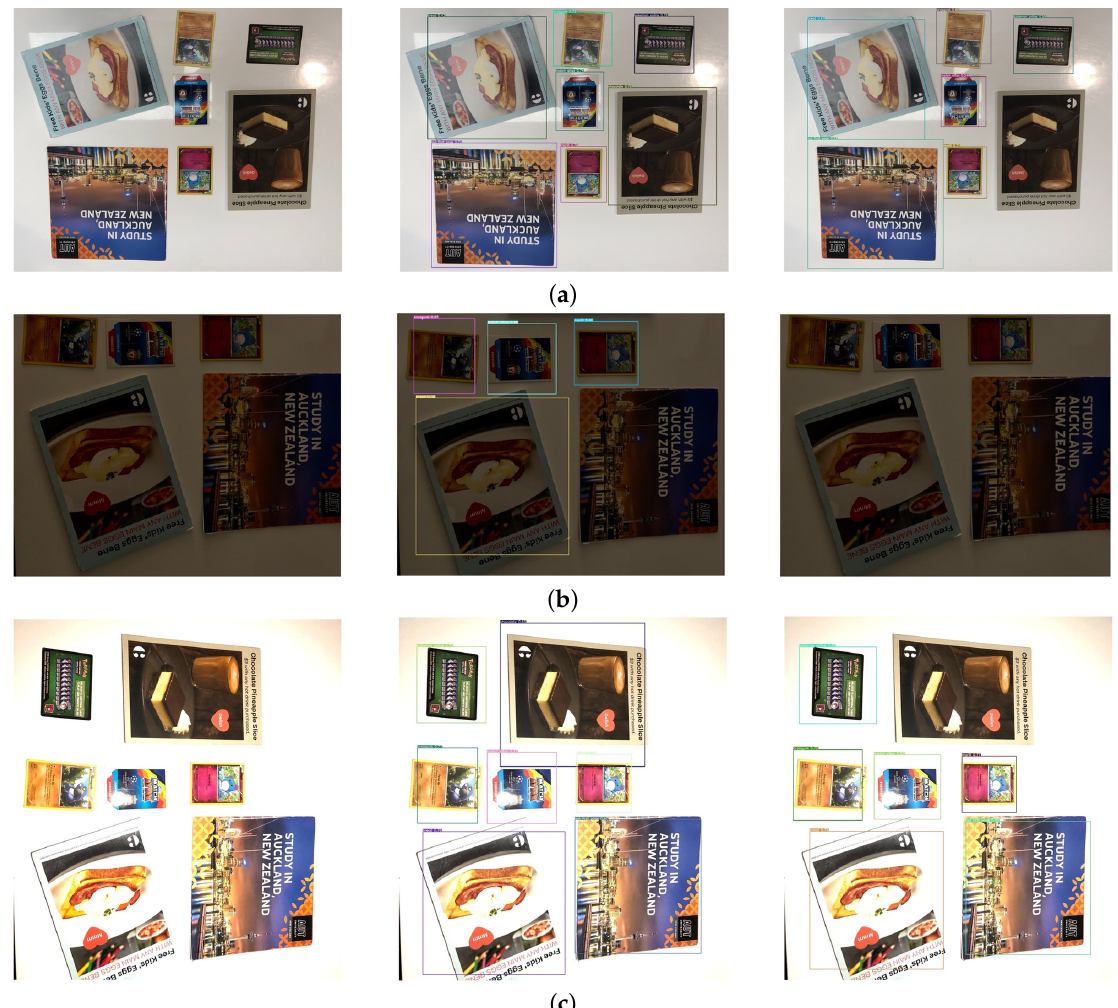
Figure 17. The input real-time images (left column) and detection results under different lighting conditions for the YOLOv3 model (middle column) and YOLOv3 tiny model (right column). ( a ) Indoor lighting; ( b ) Low lighting; ( c ) High contrast